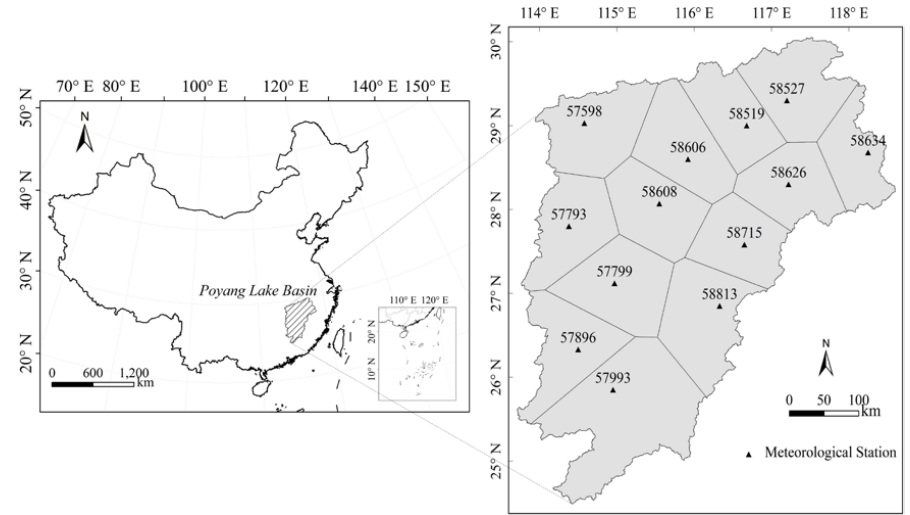
Figure 1. Study area and location of the selected stations along with their Thiessen polygons.